Question: Looking at the figure, what chart type is it?
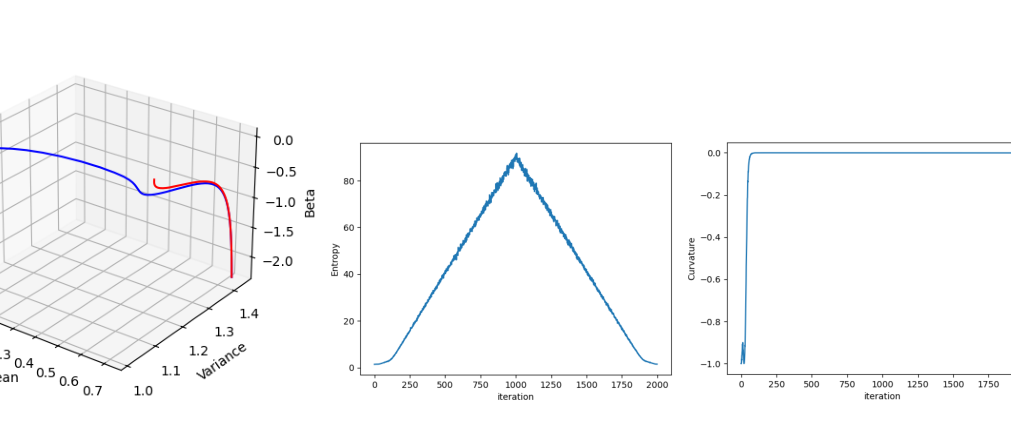
Answer: line